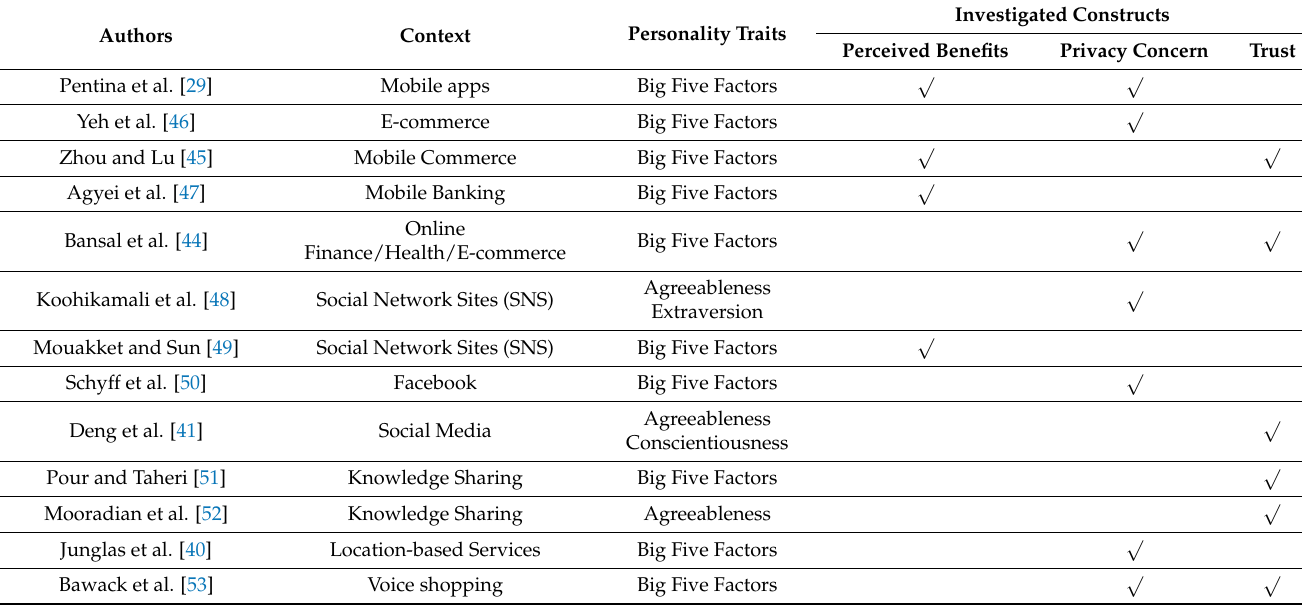
Table 1. Research related to personality traits and privacy-perception